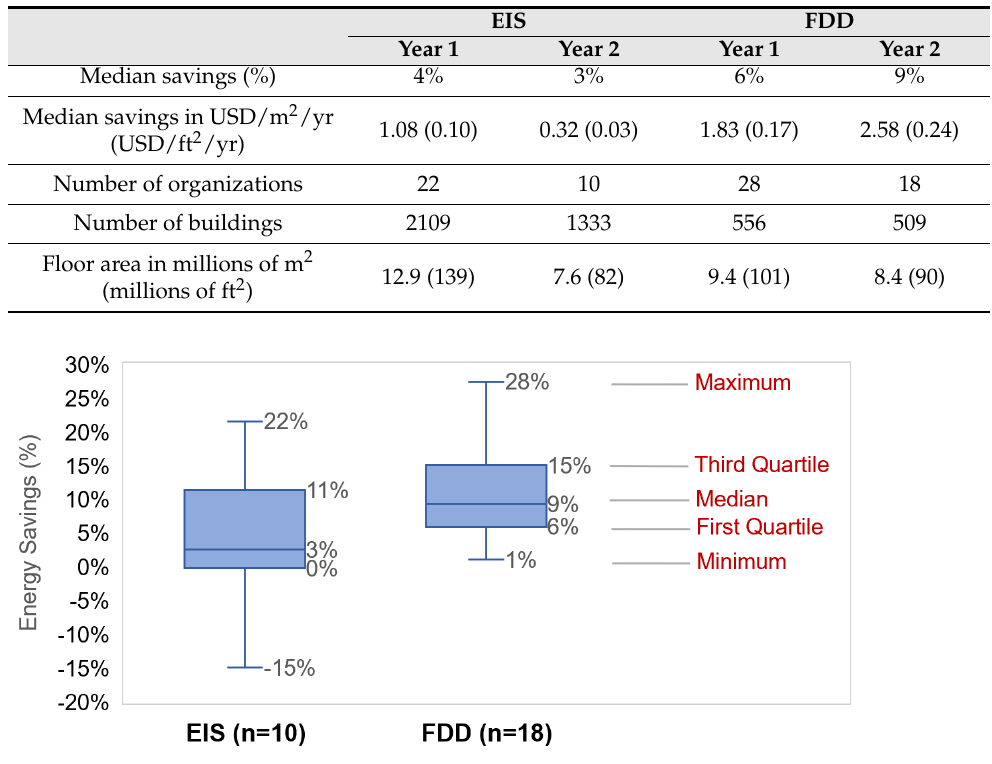
Figure 2. Second-year energy savings for organizations with EIS and organizations with FDD.